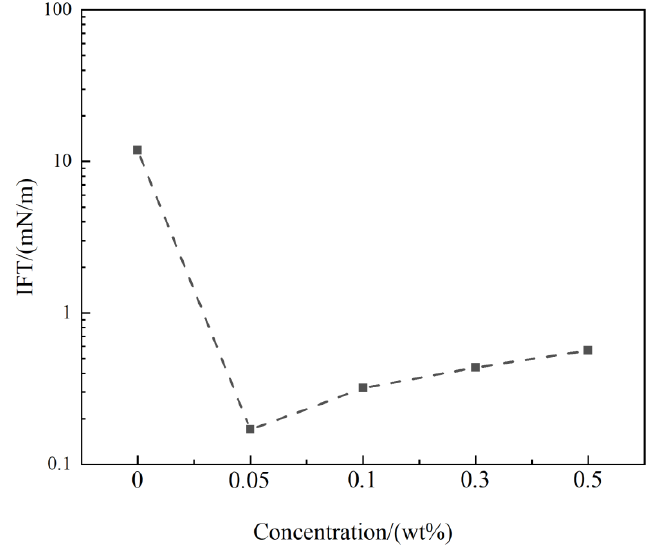
Figure 6. IFT between different concentrations of ASB surfactant and mixed oil.